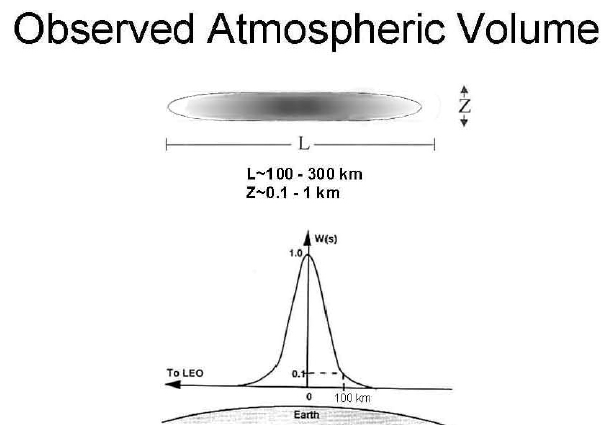
Fig. 3. Top: schematic depiction of tubular volume over which the atmosphere contributes information to a single occultation measure- ment. The intensity of shading in the tube represents the relative weighting of atmospheric properties that contribute to the value re- trieved at the center of the tube. For typical atmospheric structures, L and Z are approximately 300 and 1km respectively. Bottom: typ- ical along-track weighting function for a single radio occultation measurement (Melbourne et al., 1994). Most of the information is contributed by a mesoscale atmospheric volume centered at the ray tangent point (Anthes et al.,